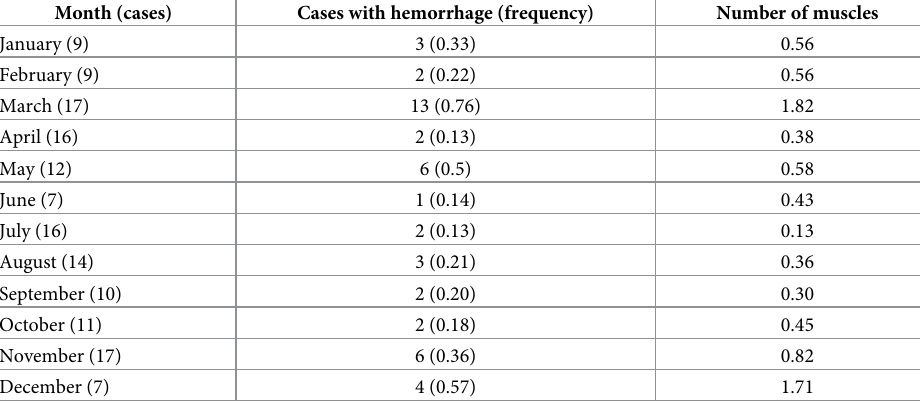
Table 2. Monthly frequency of intramuscular hemorrhage. Month (cases) Cases with hemorrhage (frequency) Number of